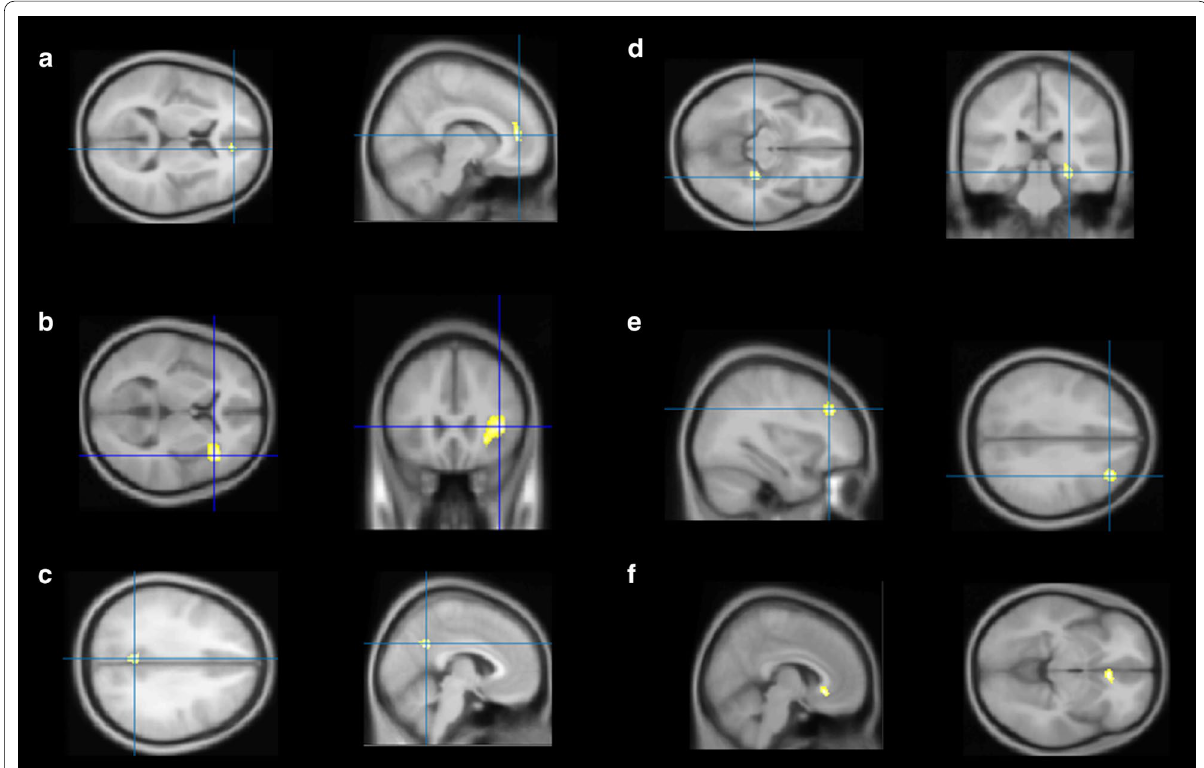
Fig. 1 Anatomical localization of significant perfusion SPECT findings (p-voxel < 0.001 uncorrected, k > 20). The increased number of depressive episodes is correlated with decreased perfusion of: a the right anterior cingulate cortex (ACC) (T-voxel max max 3.85, k 26), c the left precuneus (T-voxel max 3.85, k 62), d the right medial temporal cortex (T-max = = = = middle frontal cortex (T-voxel max 3.85, k 106). f The increased depression duration is correlated with decreased perfusion of the right ACC = = (T-voxel max 5.31, k = =